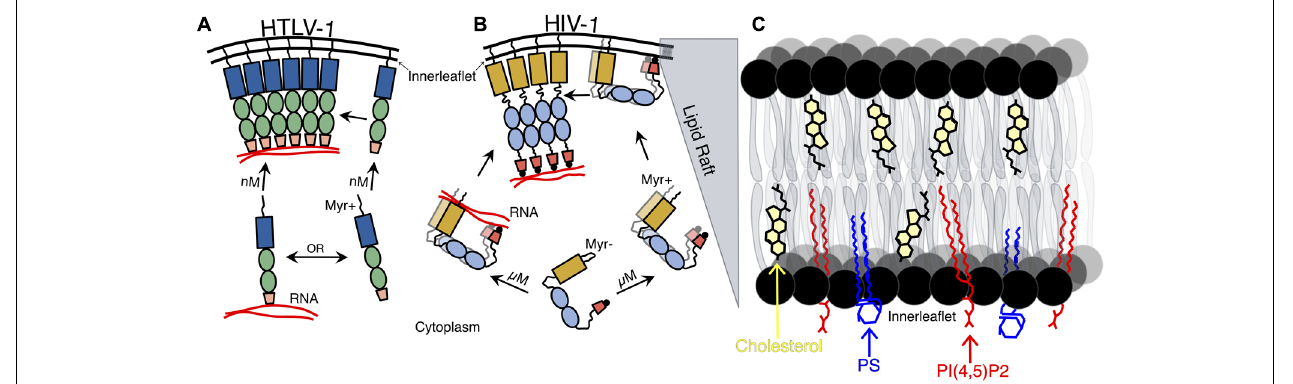
FIGURE 2 | Schematic representation of HTLV-1 and HIV-1 Gag– membrane association. (A) HTLV-1 Gag associates with the plasma membrane (PM) as a monomer and is found in the PM at nM concentrations. HTLV-1 Gag is shown as recruiting viral RNA after its association with the inner leaflet of the PM (though monomeric Gag may recruit the viral RNA in the cytoplasm and are transported together to the PM). (B) Concentration- dependent HIV-1 Gag dimerization and translocation to the PM. HIV-1 Gag must reach a critical cytoplasmic concentration ( ∼ 0.5 μ M) in order for Gag–Gag dimers to form and subsequent Gag–membrane association